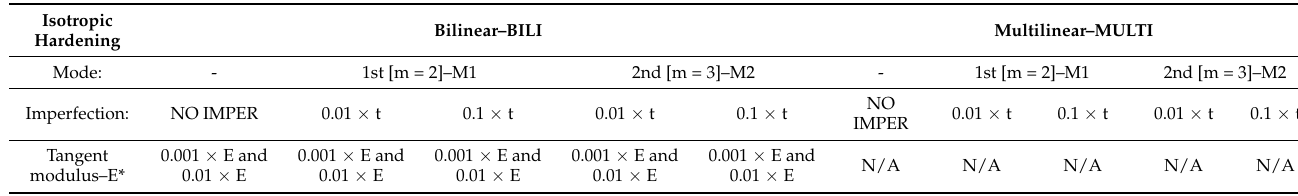
Table 5. Considered cases of numerical